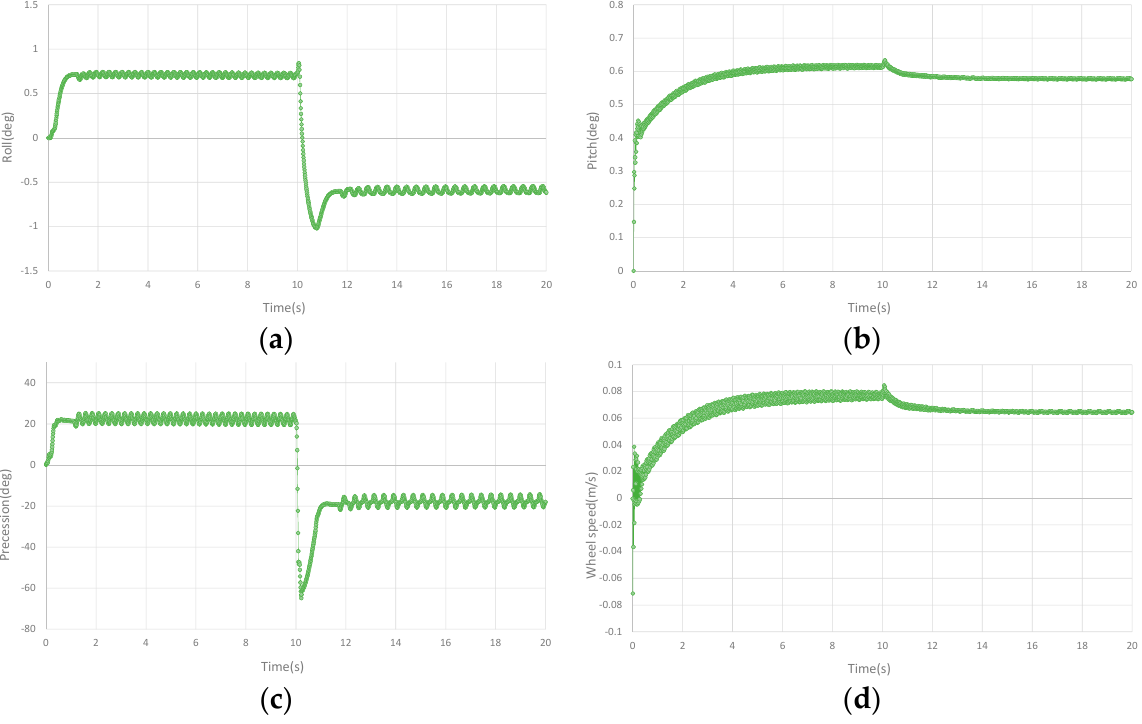
Figure 5. Curves of the unicycle robot in simulation. ( a ) The roll angle curve in the simulation. ( b ) The pitch angle curve in the simulation. ( c ) The precession angle curve in the simulation. ( d ) The speed curve in the simulation.